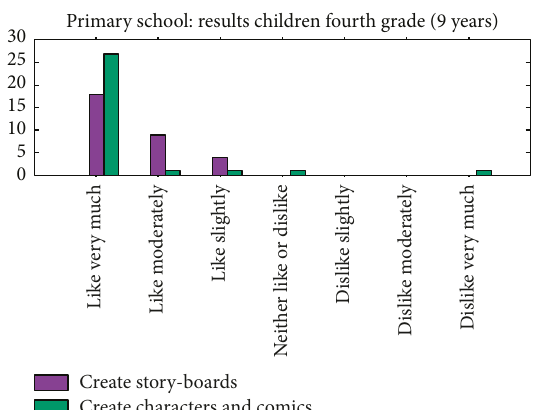
Figure 11: Results of the satisfaction survey for the second intervention in the fourth grade for children aged 9 years (primary school).